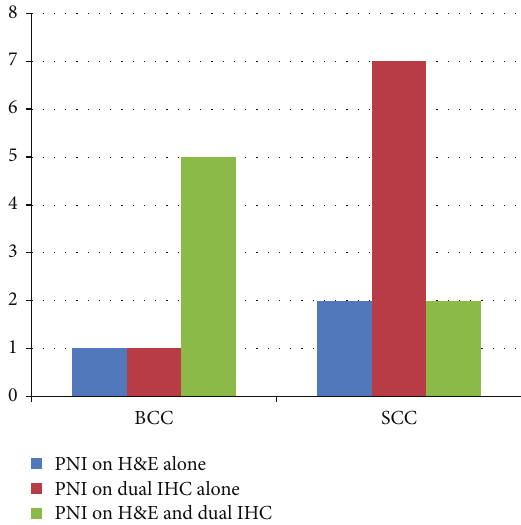
Figure 2: Comparative analysis between routine H&E examination and dual IHC using antibodies for S-100 and AE1/3 in the evaluation of PNI in cases of BCC and SCC. PNI: perineural invasion; H&E: hematoxylin and eosin; IHC: immunohistochemistry; BCC: basal cell carcinoma; SCC: squamous cell carcinoma.